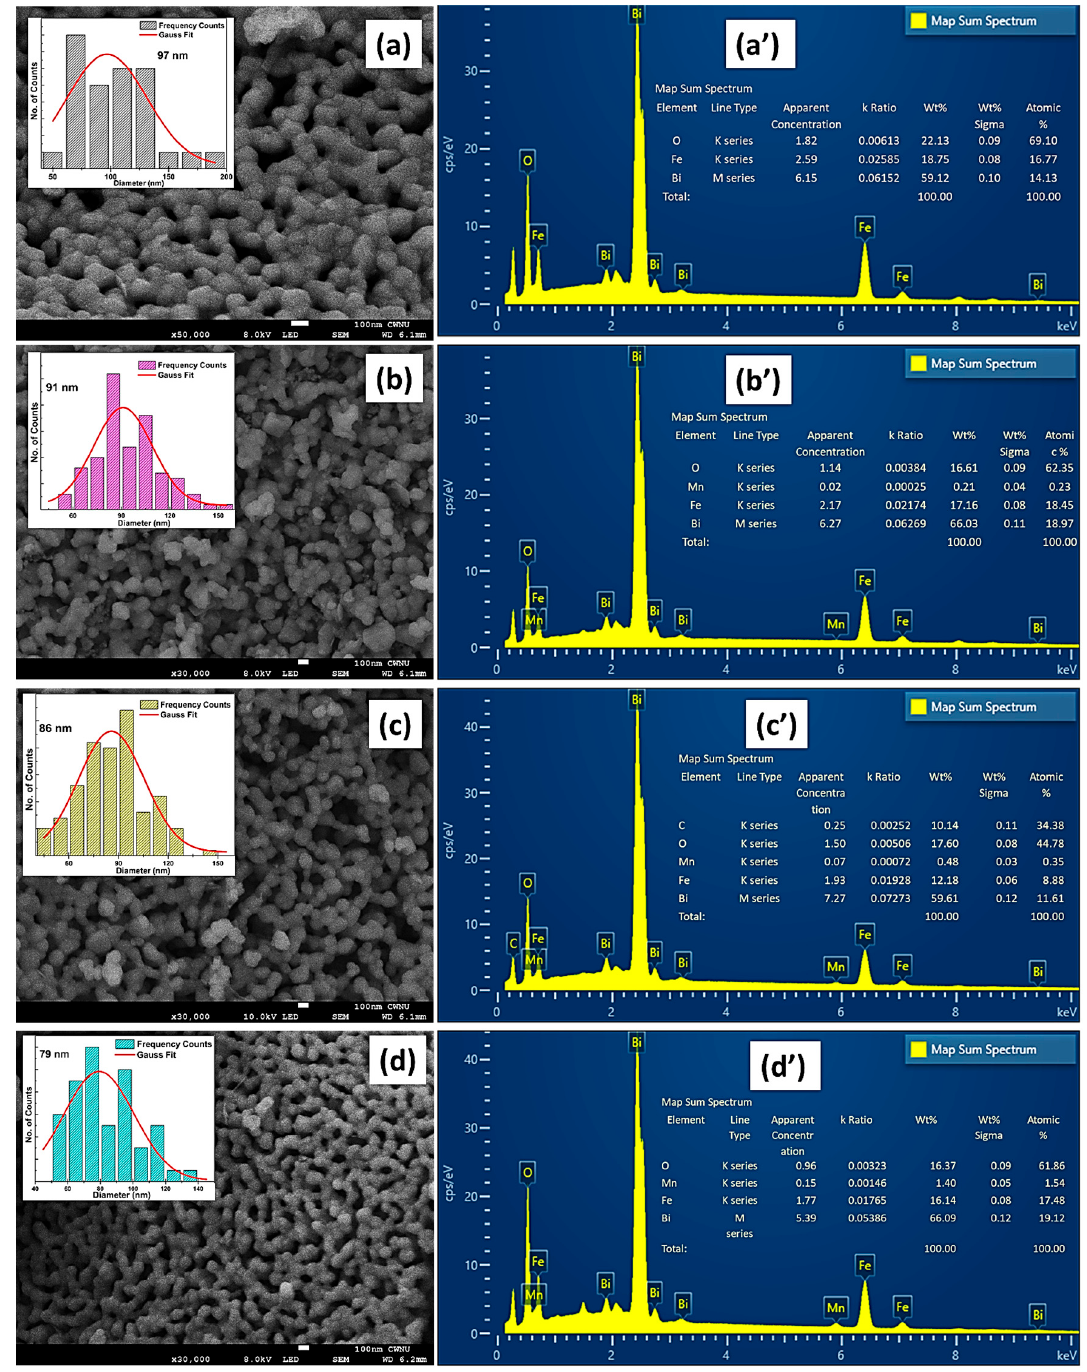
Figure 4. ( a – d ) FESEM micrographs of BFO, BFMO1, BFMO5, and BFMO10, respectively; inset shows the fitted histograms of size distribution; ( a’ – d’ ) EDX spectra of corresponding BFO, BFMO1, BFMO5, and BFMO10.